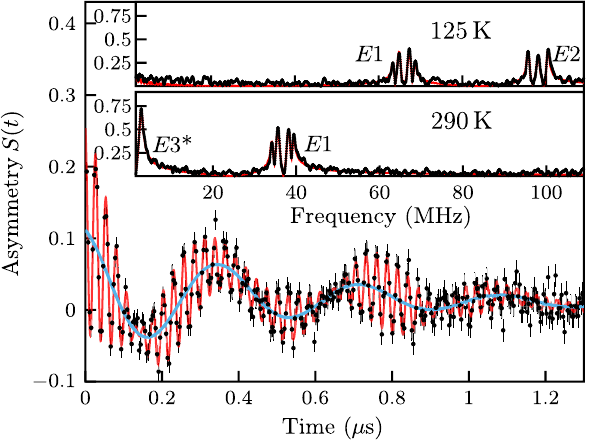
¼ 20 mT ⊥ c at T ¼ 290 K. ext is ext